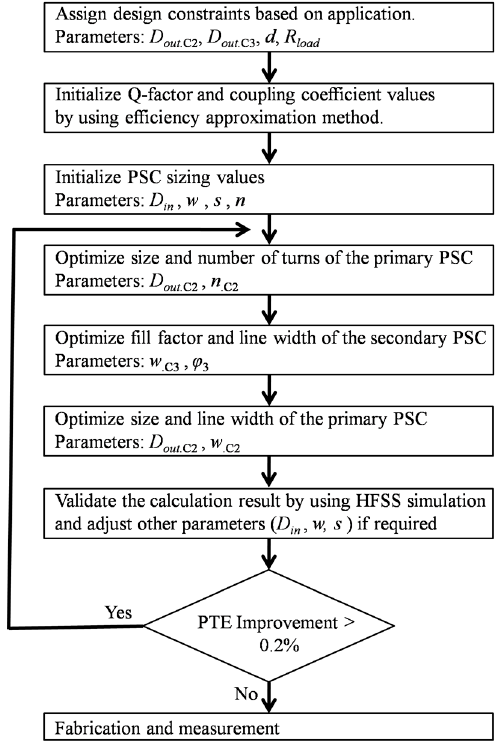
Figure 12. Iterative design flowchart.